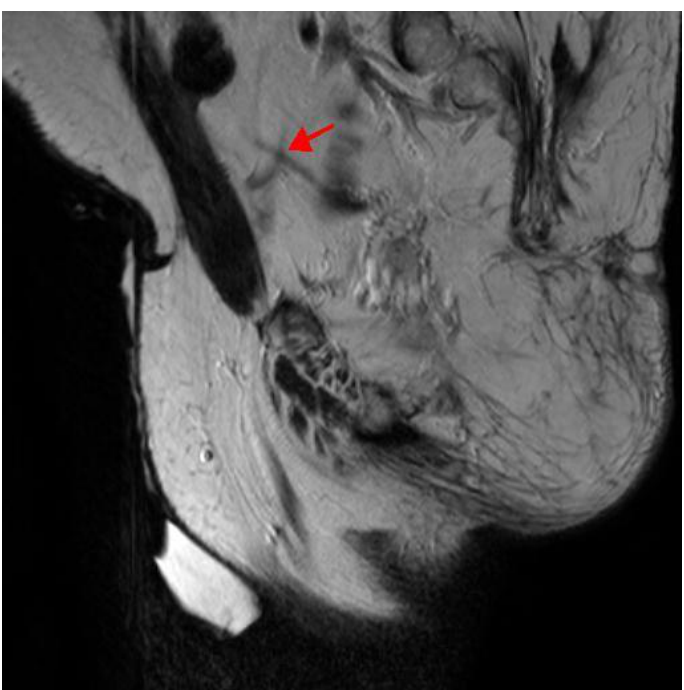
FIGURE 3 . T-2 weighted sagittal image shows left vas deferens traversing the left ureter (arrow).